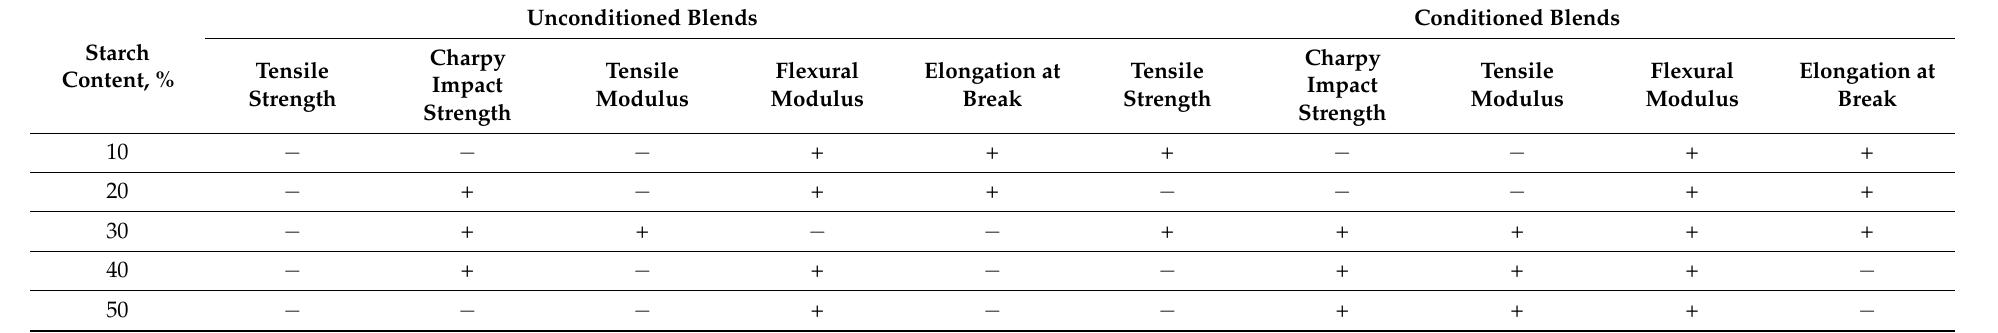
Table 5. Effects on mechanical properties of sunflower oil-based additive (“+”: positive change relative to an additive-free blend of a suitable composition; “ − ”: negative change relative to an additive-free blend of a suitable composition).